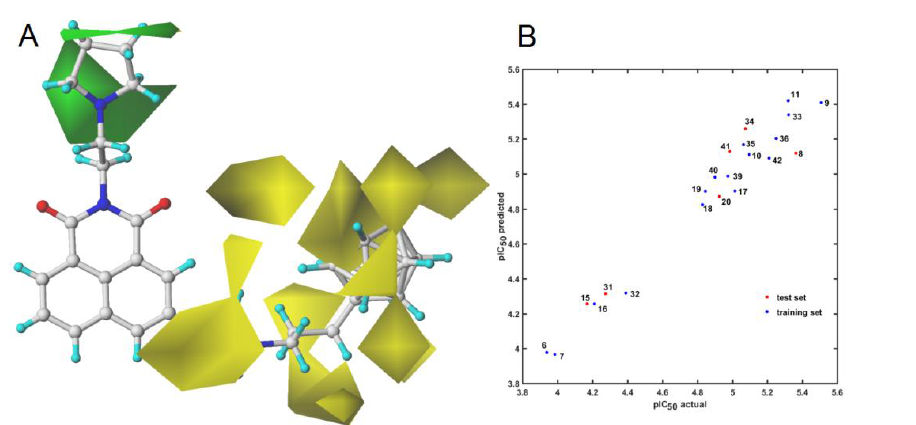
Figure 14. The favorable (green) and unfavorable (yellow) steric contributions with the most potent molecule 9 as a reference ( A ) and pIC 50 actual vs. predicted plot for the training and test sets ( B ).